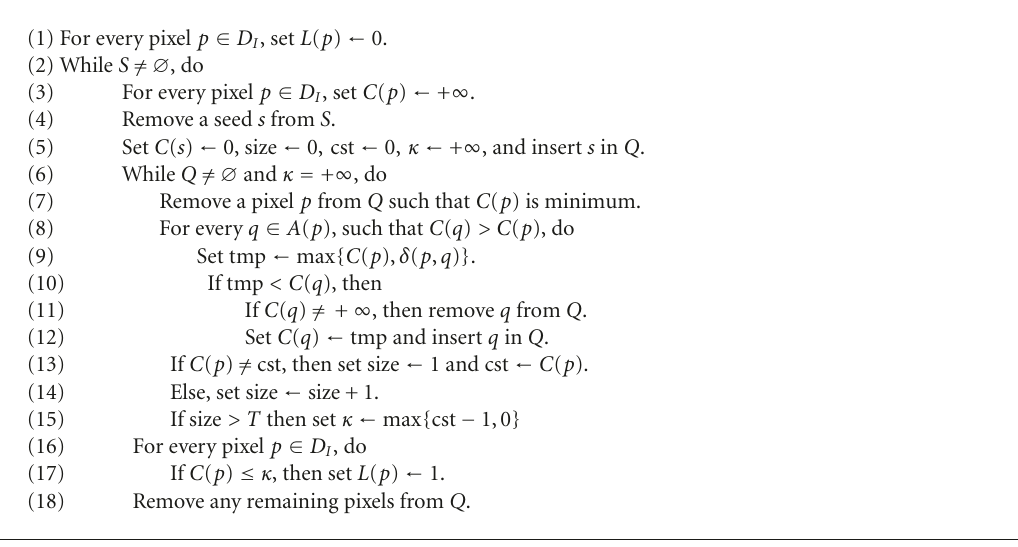
Algorithm 1: Single object definition without seed competition.